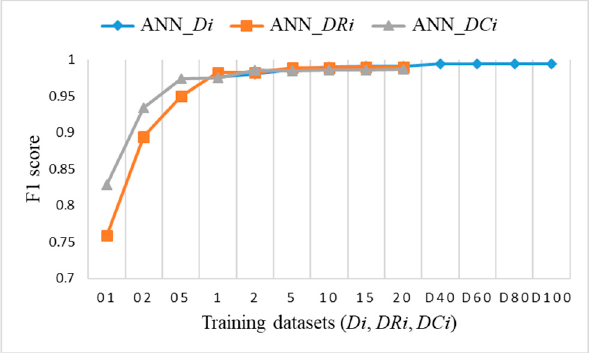
Figure 19. F1 score on test dataset for training datasets Di , DRi , DCi for ANN.